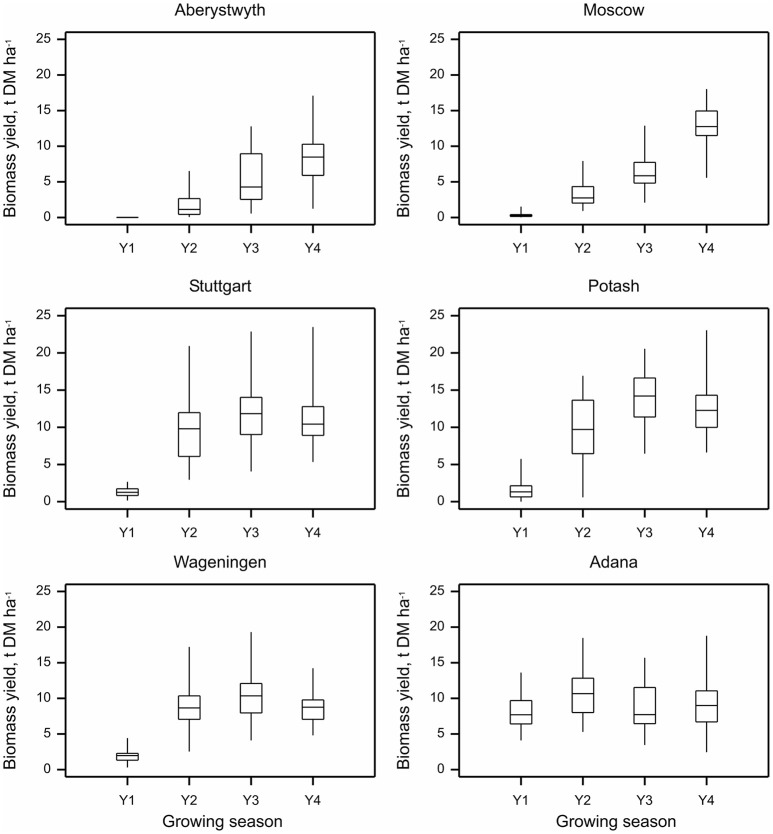
Annual biomass yield of Miscanthus (15 genotypes pooled) at six trial locations over four growing seasons 2012–2015 (Y1–Y4). Whiskers denote the overall range at each location within each year, boxes denote interquartile ranges and within this the horizontal bar denotes the median.